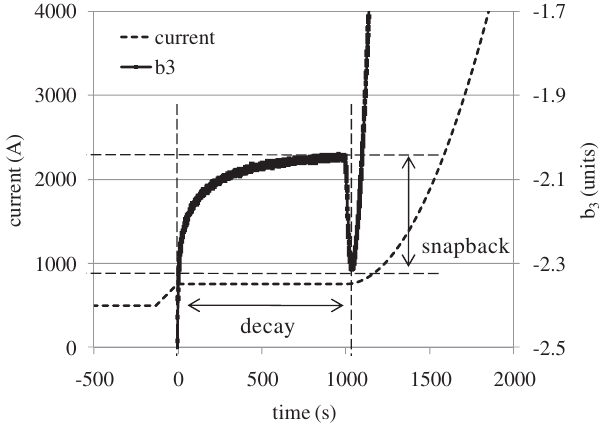
FIG. 1. The dipole current and the normal sextupole b 3 as a function of time. Magnets reach injection current at t ¼ 0 , and energy ramp starts at t ¼ 1000 s